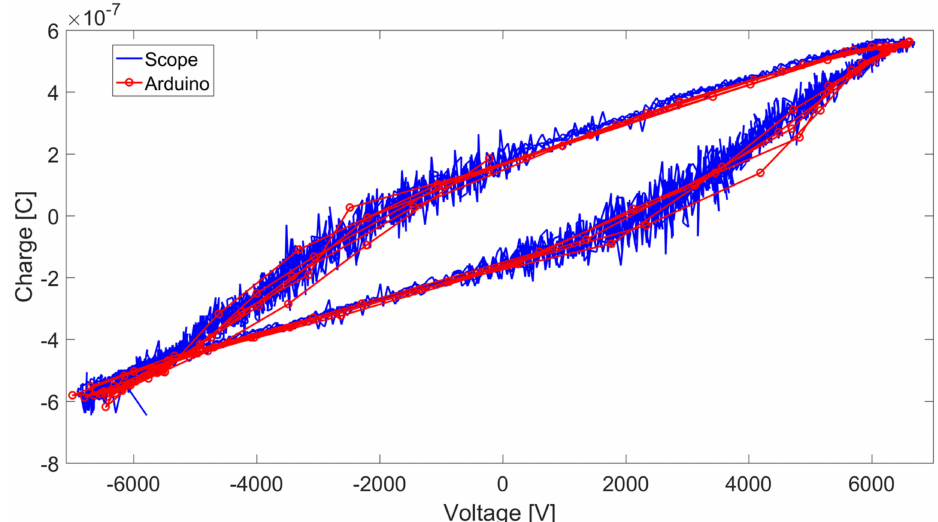
Figure 7. Q-V Lissajous figures detected by means of the dedicated measurement setup (continuous blue line) and by means of the micro-controller (red line with